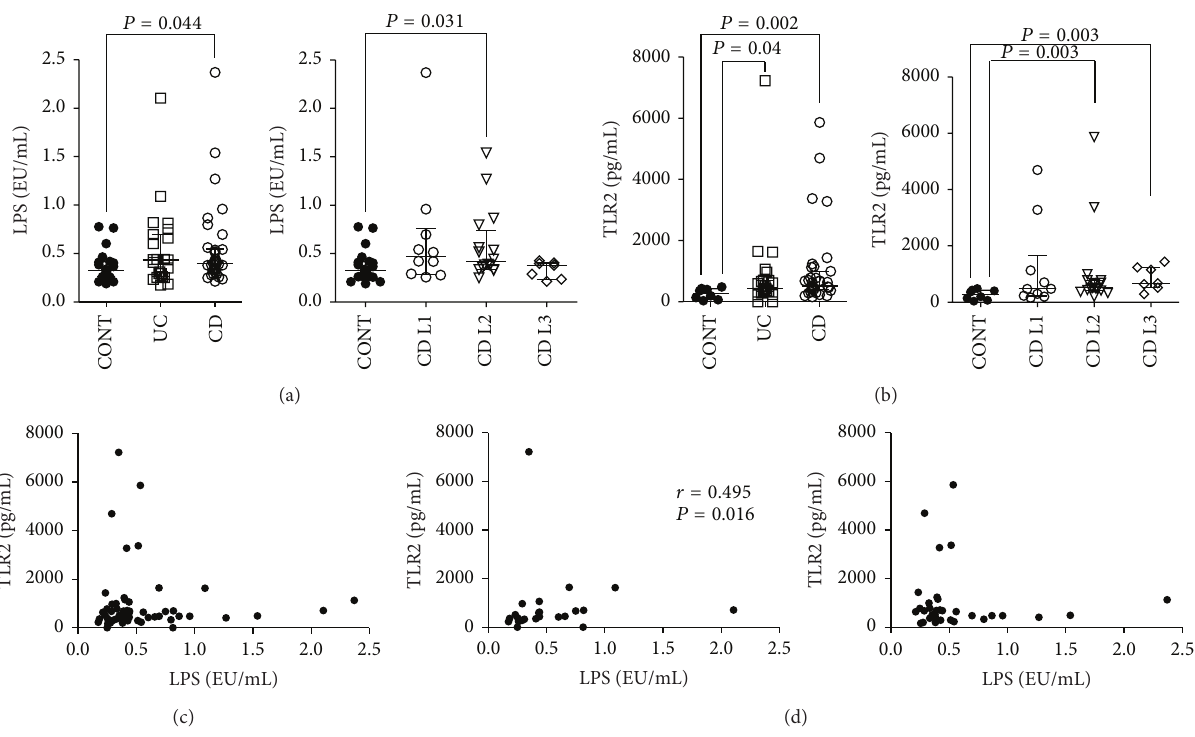
patients with colonic disease (L2 and L3) were taken into account, correlations between D-Dimer and F 1 + 2 and LPS levels were confirmed ( 𝑟 = 0.435 , 𝑃 = 0.042 , and 𝑟 = 0.590 , 𝑃 = 0.003 , resp.) (Figure